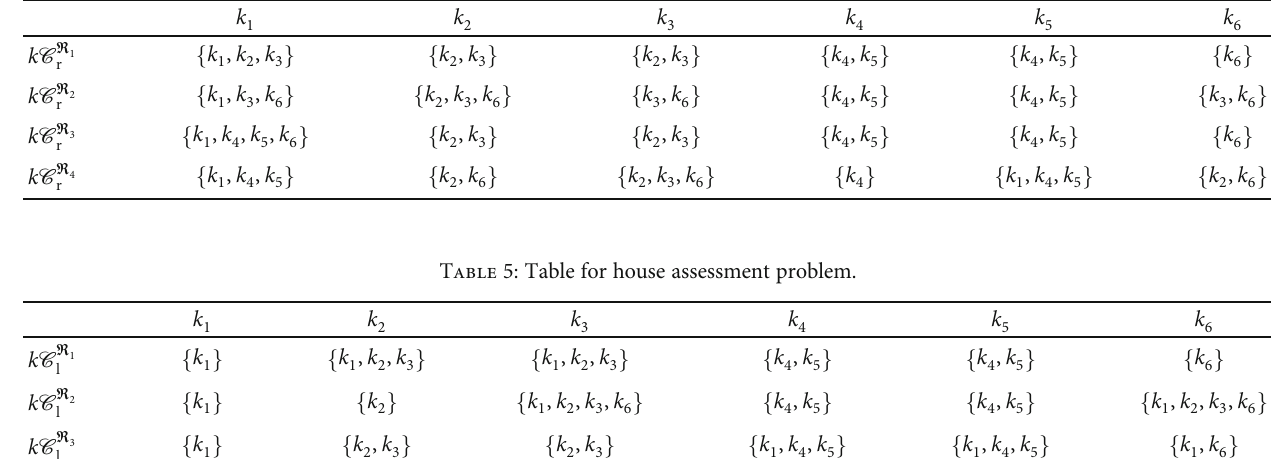
Table 4: Table for house assessment problem.